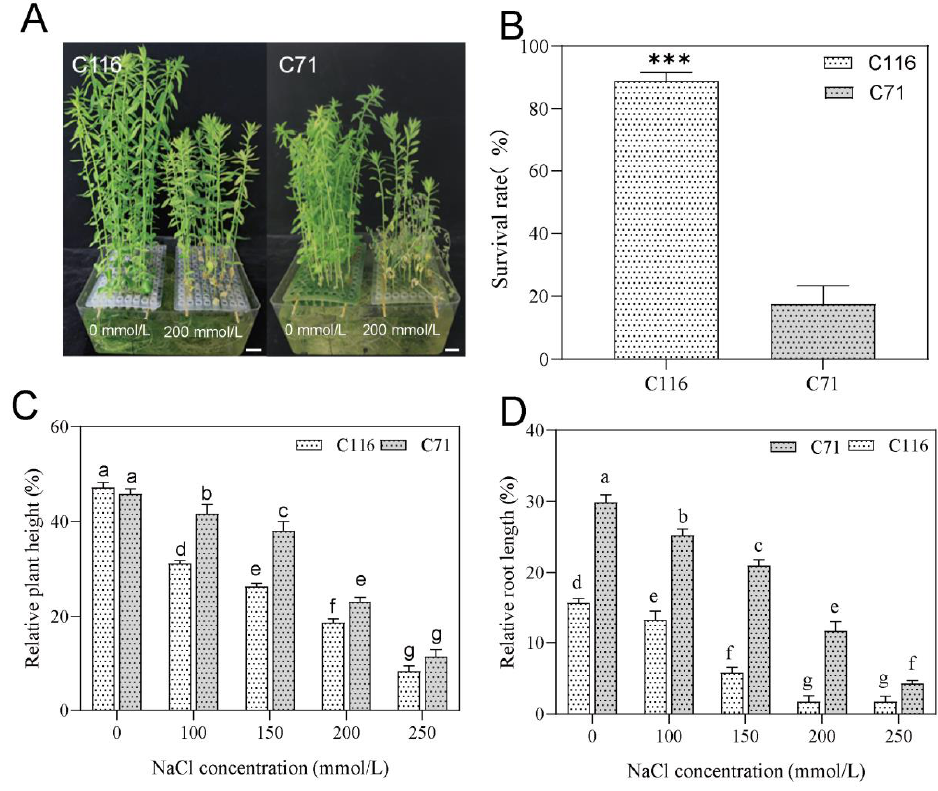
Figure 1. Statistical changes in the growth of flax under different salt concentrations. ( A ) Phenotypes (left: C116, right: C71; seedlings of the two concentrations were combined in water pots and photographed; scalebar = 1 cm). ( B ) Survival rates of the two species after 7 days of 200 mmol/L NaCl stress. Statistical differences between C116 and C71 survival rates were detected using Student’s t -test; *** p < 0.001. ( C ) Relative plant height and ( D ) relative root length under different salt concentration treatments. Error bars represent mean ± SD ( n > 3), MRT; adjusted p < 0.001 is indicated by different lowercase letters.